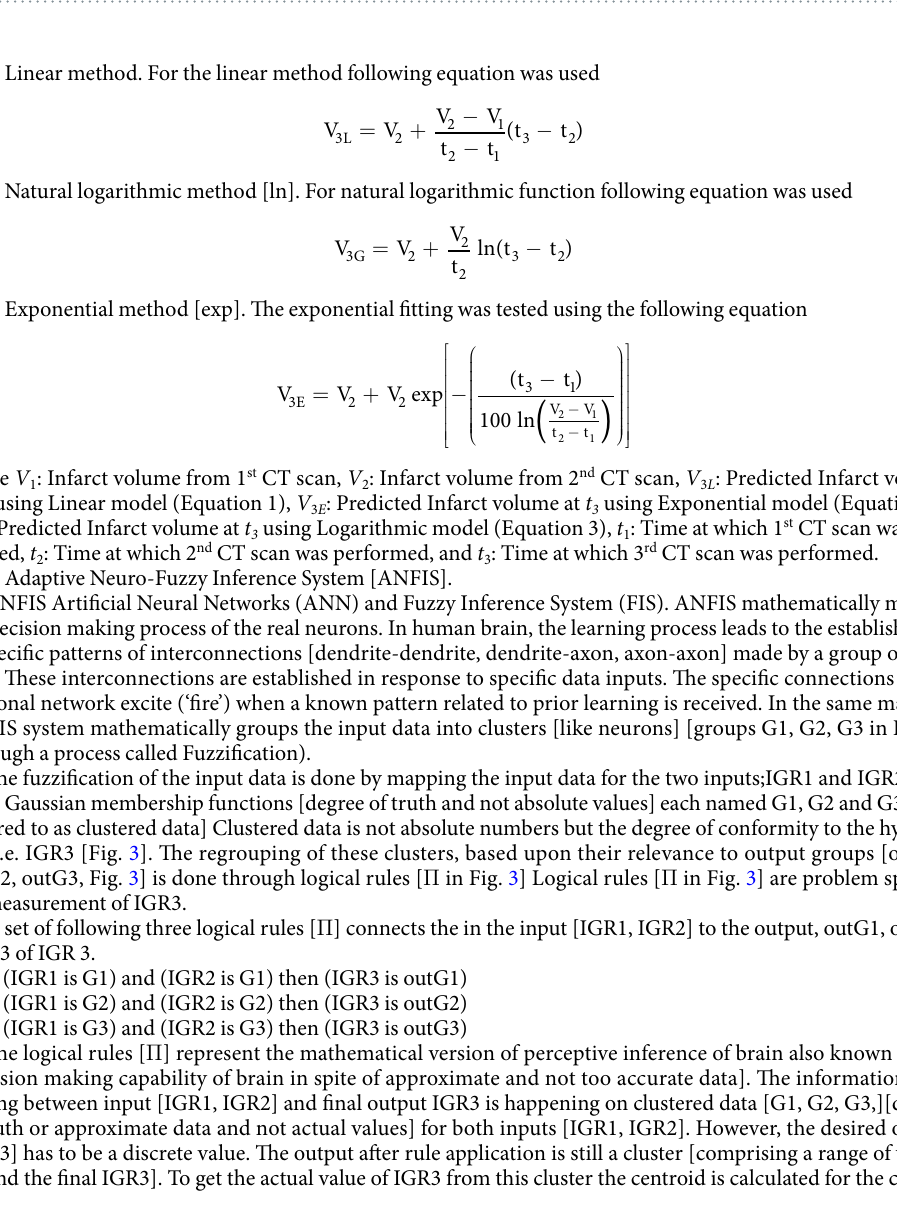
Figure 3. ANFIS structure and functioning explanation, superimposed on neurons to show the similarity between ANFIS and neuronal network structure and